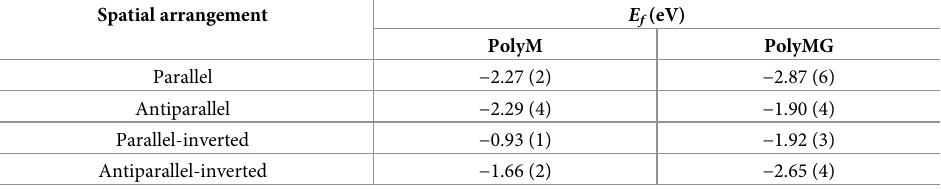
Table 2. Formation energies (eV) of the different spatial arrangements of two PolyM and PolyMG chains. Spatial arrangement